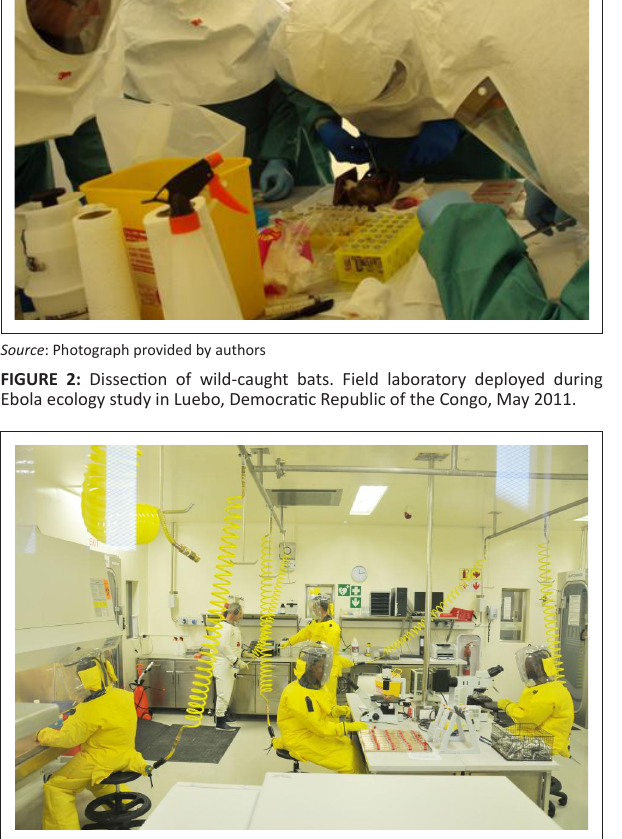
Source : Photograph provided by authors FIGURE 3: Processing and testing of blood and tissues from bats collected during the 2011 Ebola ecology expedition to Luebo, Democratic Republic of the Congo in biosafety level four facility in Sandringham-Johannesburg, South